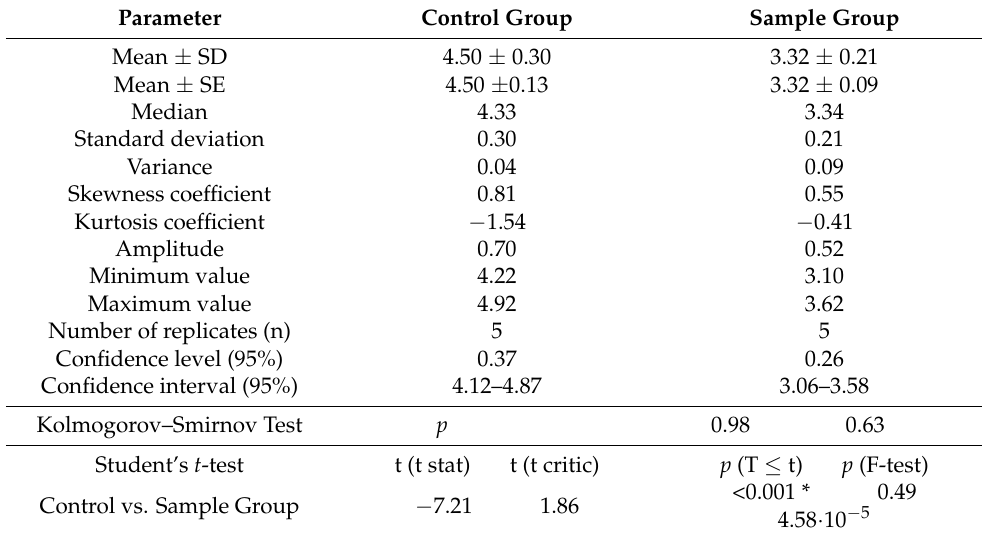
Table 1. Data processing of thyroxine values (T4 as µ g/dL).